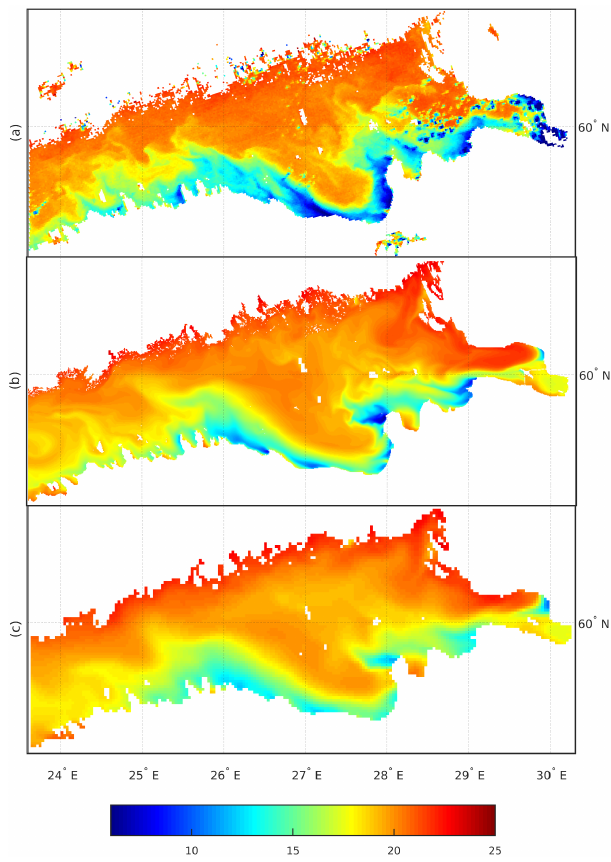
Figure 5. SST maps of the GOF on 2 August 2011: (a) MODIS data, (b) and (c) modelled SST on grids 0.5 and 2km